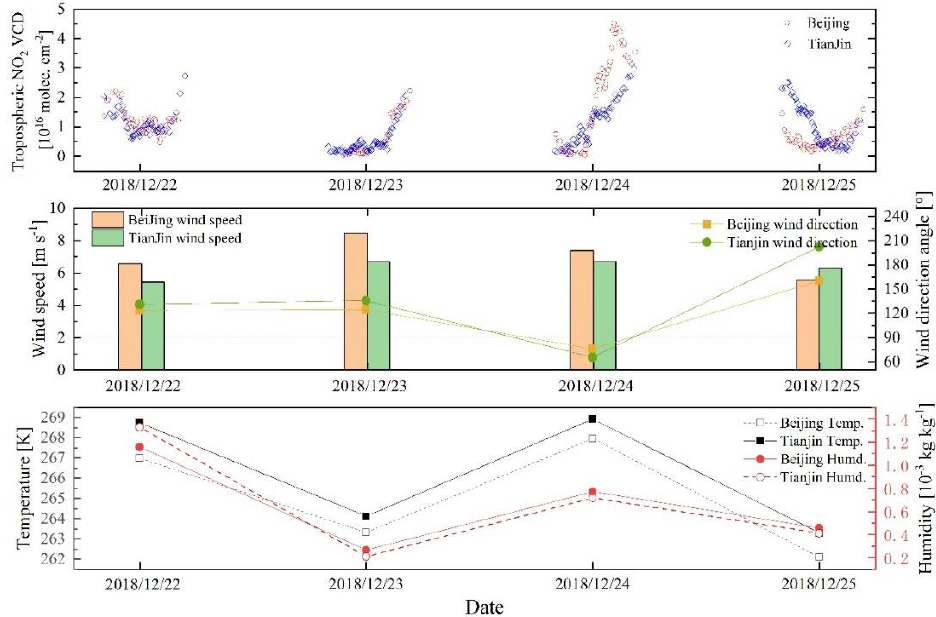
Figure 9. NO 2 variation and meteorological conditions at the Beijing and Tianjin sites on 22 December to 25 December 2018. The azimuth of the wind direction is the angle that has been rotated clockwise from the true north direction.